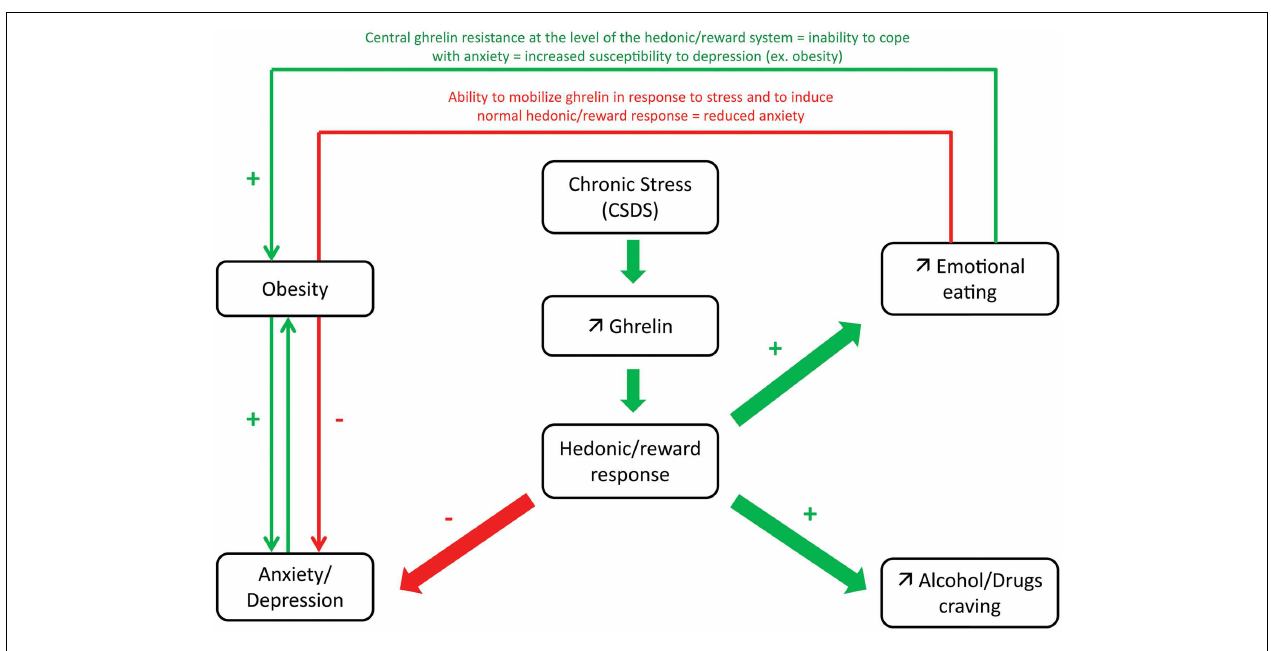
to stress or central ghrelin resistance at the level of the hedonic/reward system may explain the inability to cope with anxiety and increased susceptibility to depression. Reciprocally, depressed subjects have increased susceptibility to obesity or eating disorders (due to altered hedonic/reward response). Elevated ghrelin may also contribute to alcohol/drug craving: higher ghrelin levels correlate with higher measurements of alcohol